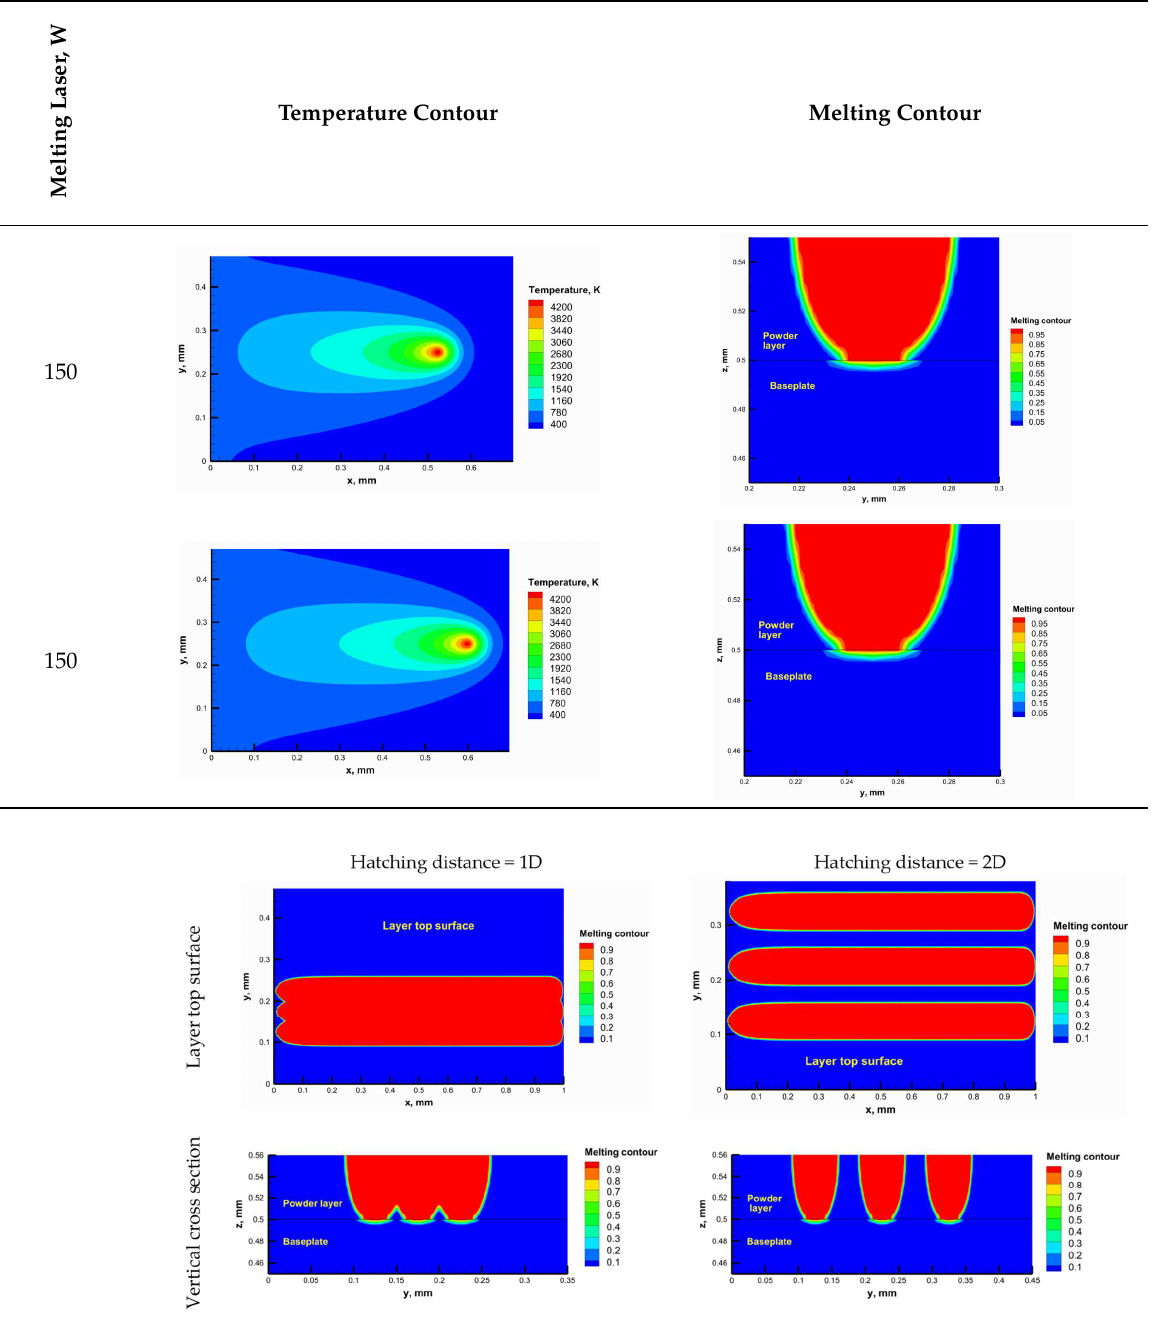
Figure 11. The top surface melting contour for different hatching distances.